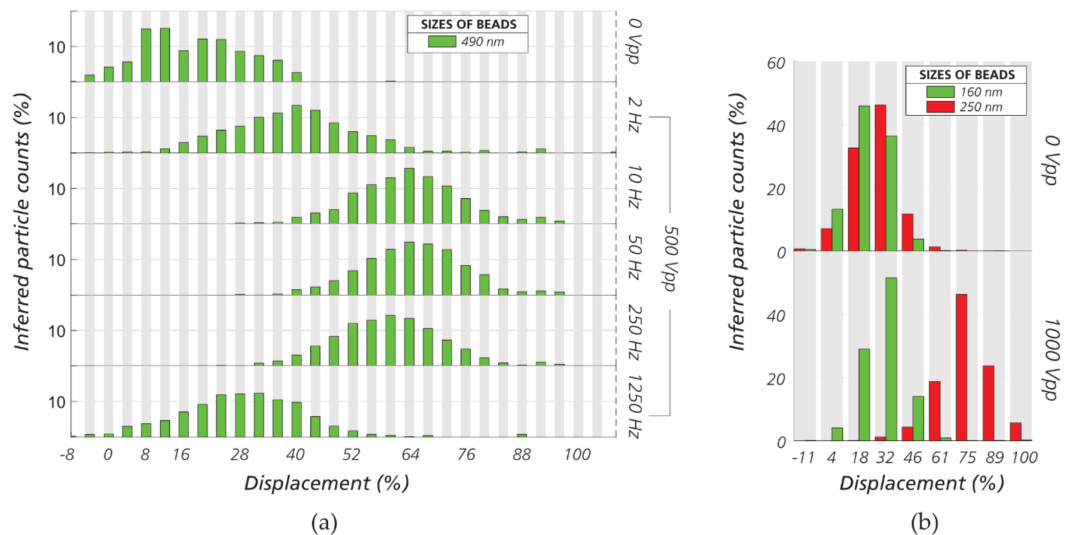
Figure 6. Displacement at outlet of nanospheres in micro-sized gap DLD devices. ( a ) Displacement of 490 nm beads in device #7 ( D C = 1.24 µ m) at 500 V PP . Medium: milliQ water + 0.1% Pluronic ® 127 ( σ = 0.5 mS / m). ( b ) Sorting of 160 nm versus 250 nm beads in device #1 ( D C = 0.66 µ m) at 1000 V PP at